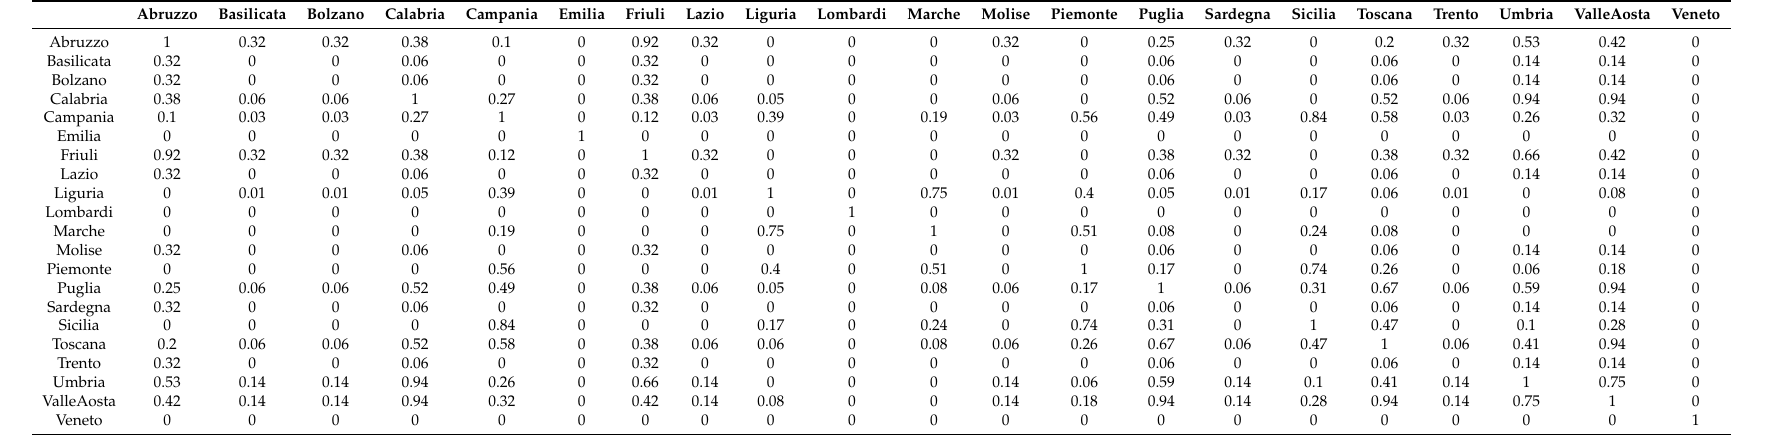
Table A20. Similarity values of Home Isolation network in the first